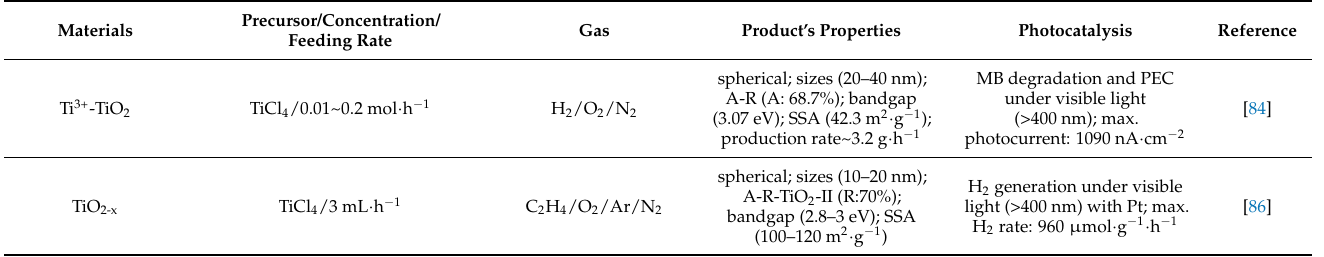
Table 1. Summary of defective and heterostructured TiO 2 nanoparticles synthesized by